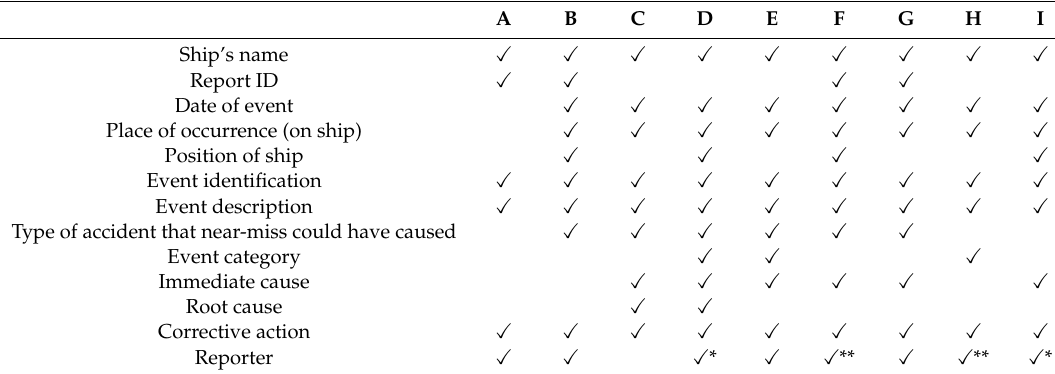
Table 2. Content of collected near-miss report